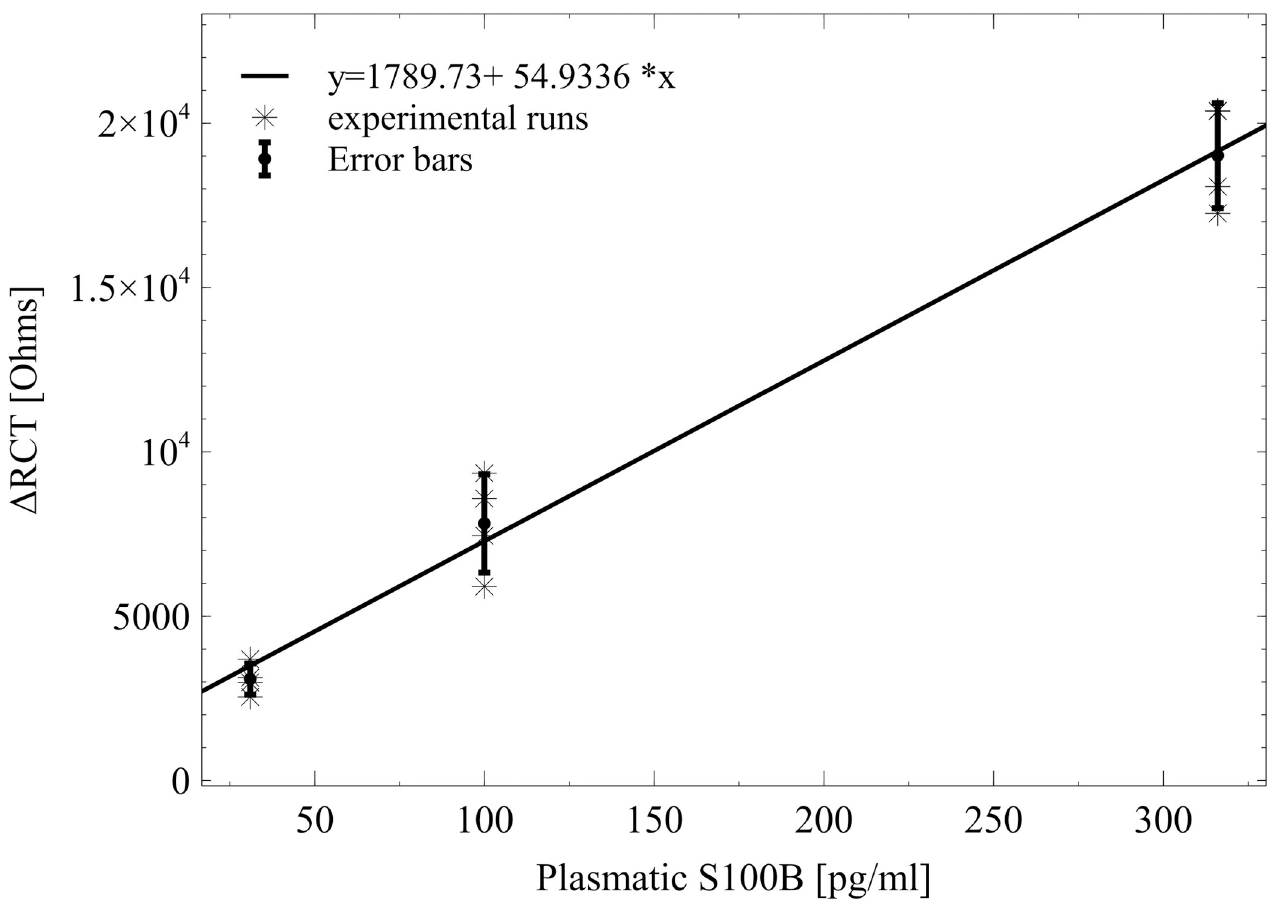
Fig 11. Calibration curve for S100B in spiked human plasma using AUIDEs. y = Δ RCT; x = [S100B] (pg/mL).